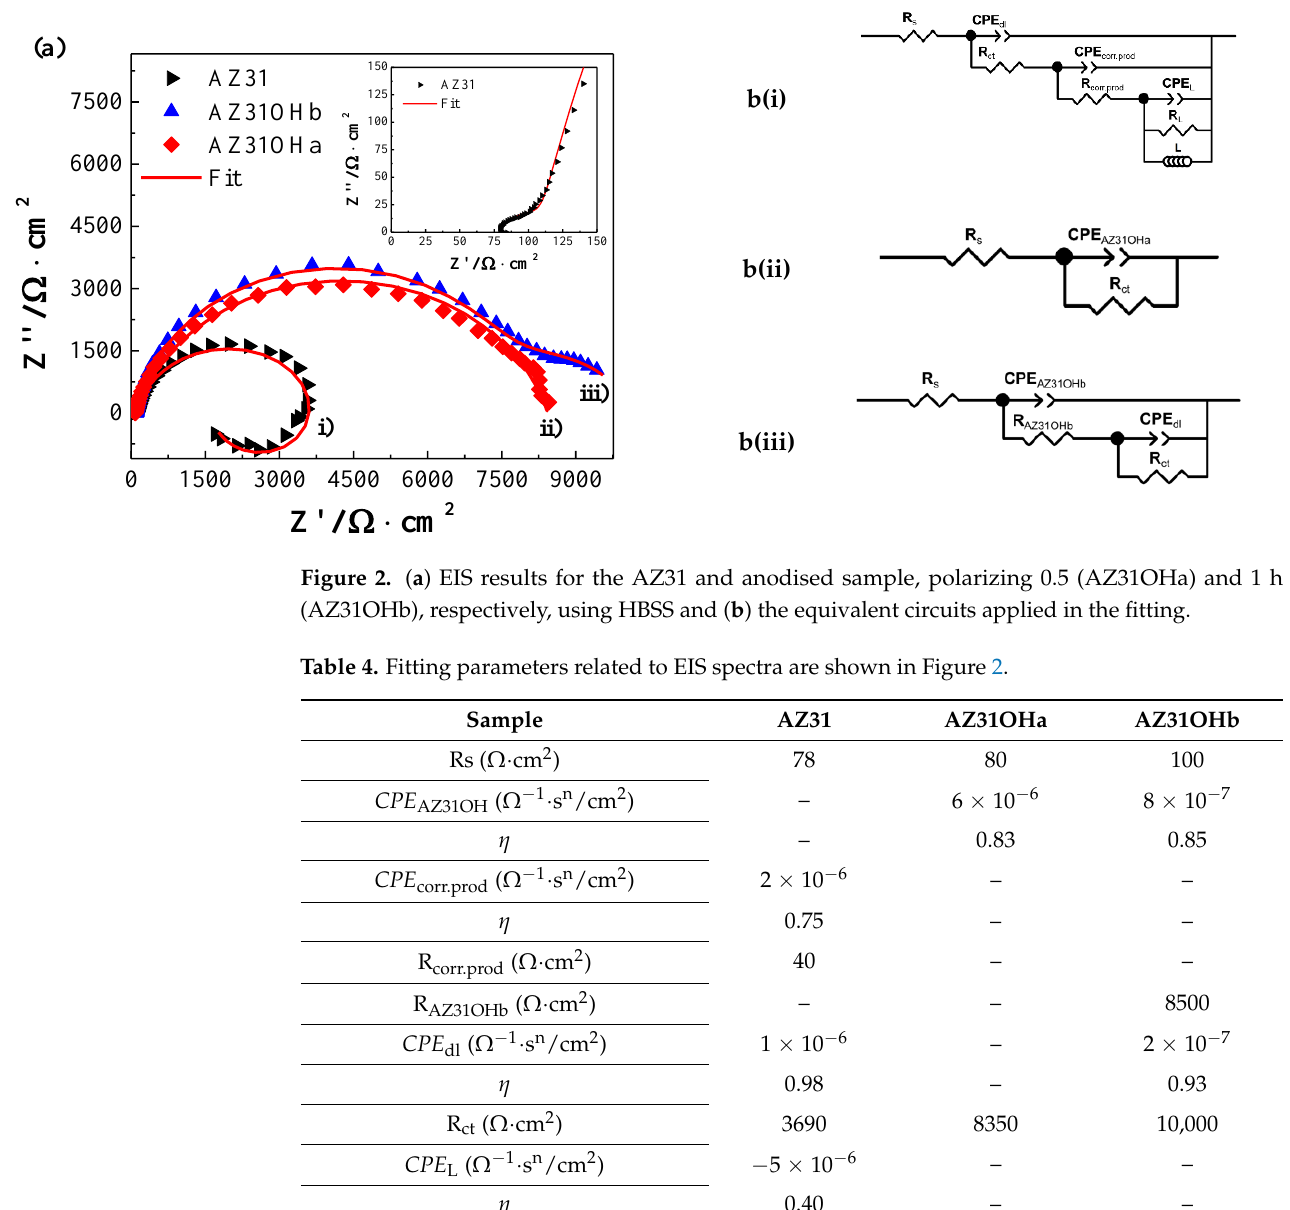
Table 4. Fitting parameters related to EIS spectra are shown in Figure 2. Sample